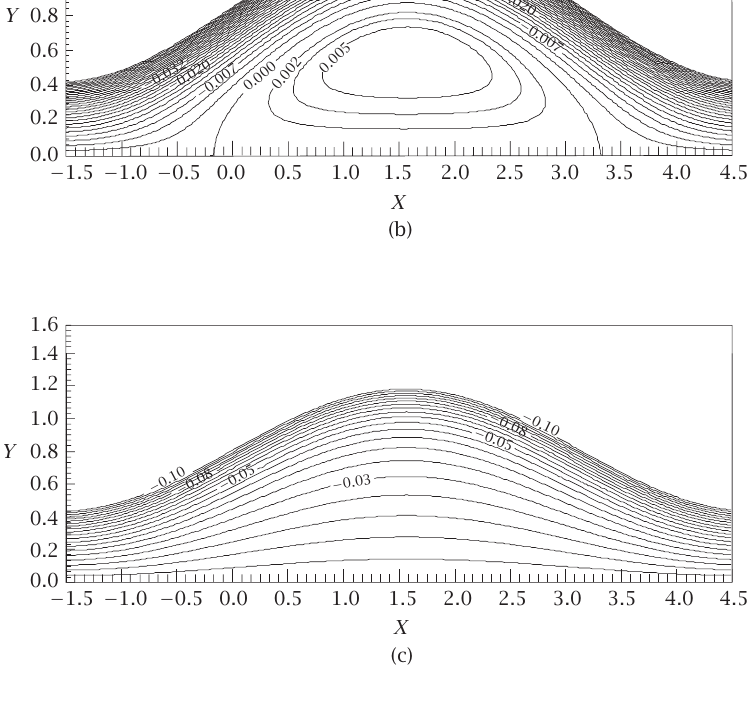
Figure 6.6 . The streamlines for K = 1, ϕ = 0 . 4, δ = 0 . 06, θ ( 2 ) = 0 . 8, and Re = 1, at (a) M = 2, (b) M = 5, and (c) M =